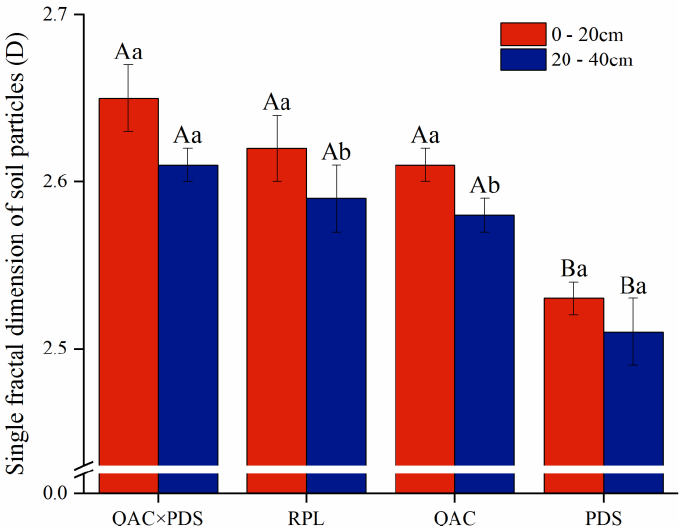
Figure 4. Single-fractal dimension of soil particles under four vegetation restoration types. Different letters indicate significant differences at the level of p < 0.05. Capital letters indicate the comparison of the same soil depth of different vegetation types. Lowercase letters indicate the comparison of different soil depths of the same vegetation type.